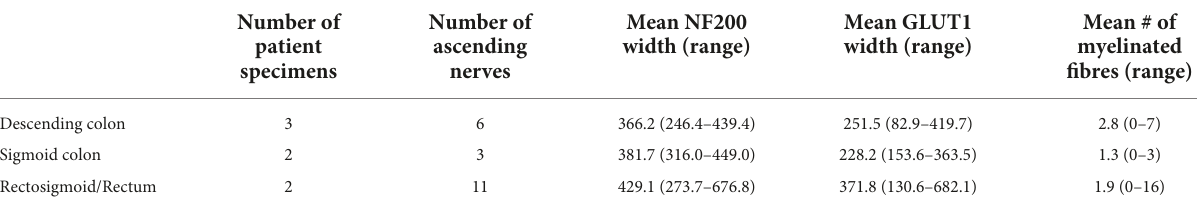
TABLE 2 The width of ascending nerves by neurofilament-H (NF200) and glucose transporter 1 (GLUT1) and number of myelinated fibres within ascending nerves separated by region of large